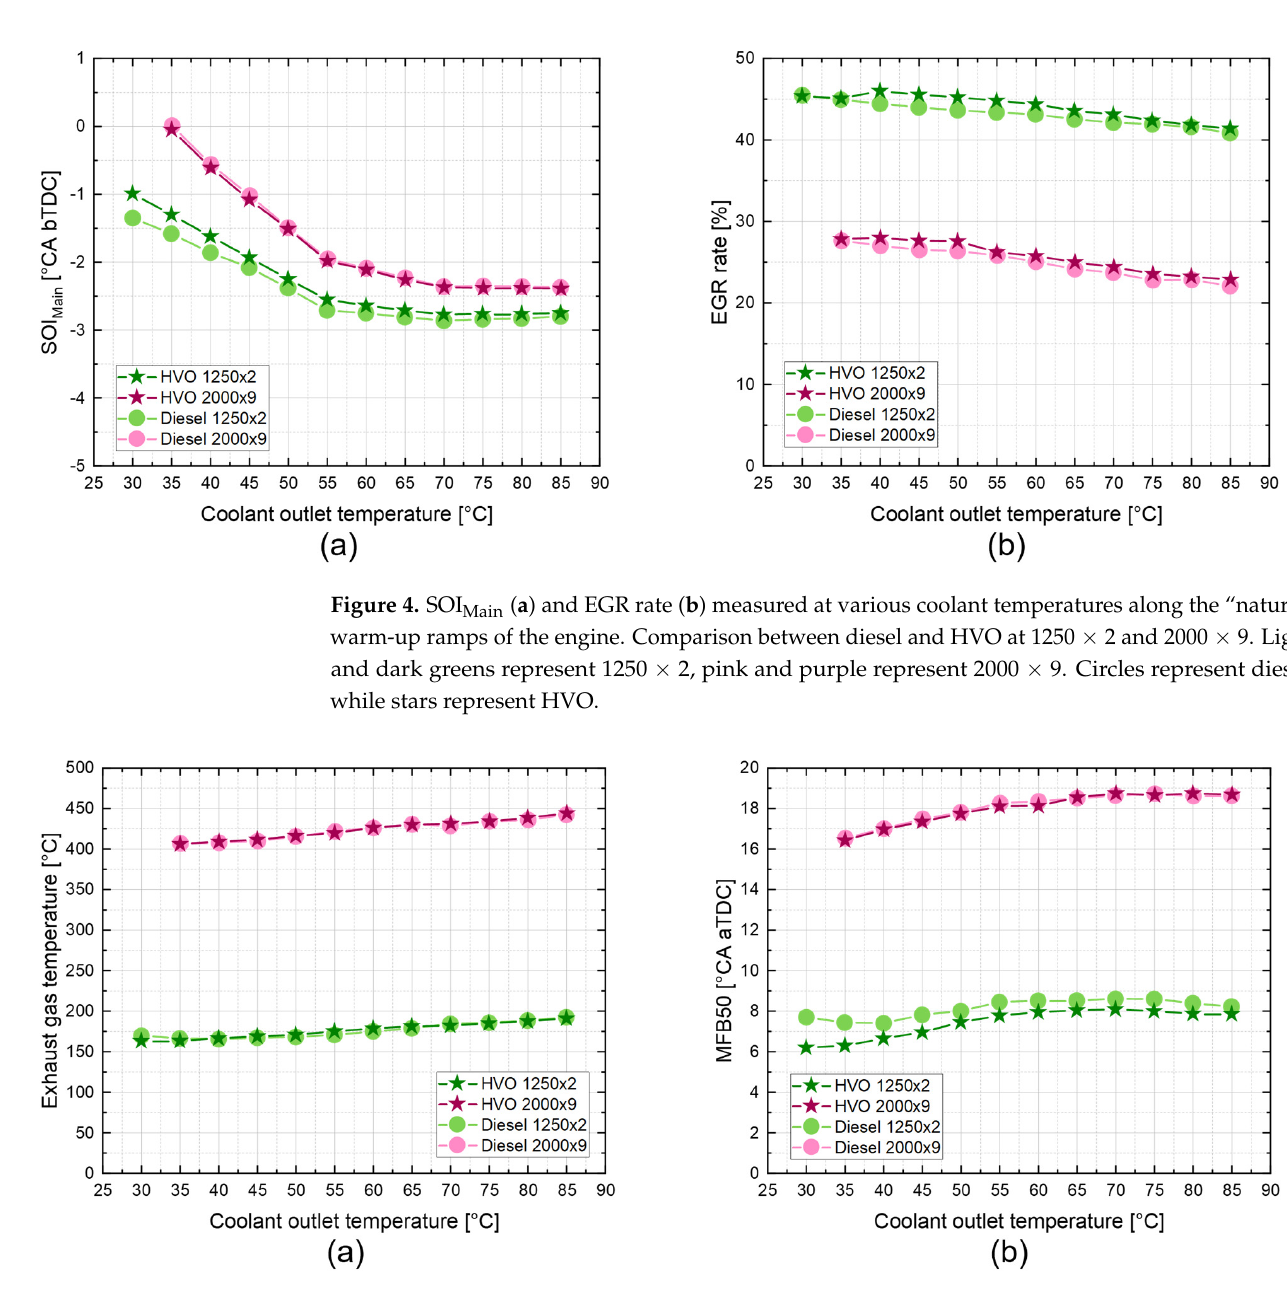
Figure 5. Exhaust gas temperature ( a ) and MFB50 ( b ) measured at various coolant temperatures along the “natural” warm-up ramps of the engine. Comparison between diesel and HVO at 1250 × 2 and 2000 × 9. Light and dark greens represent 1250 × 2, pink and purple represent 2000 × 9. Circles represent diesel, while stars represent HVO.